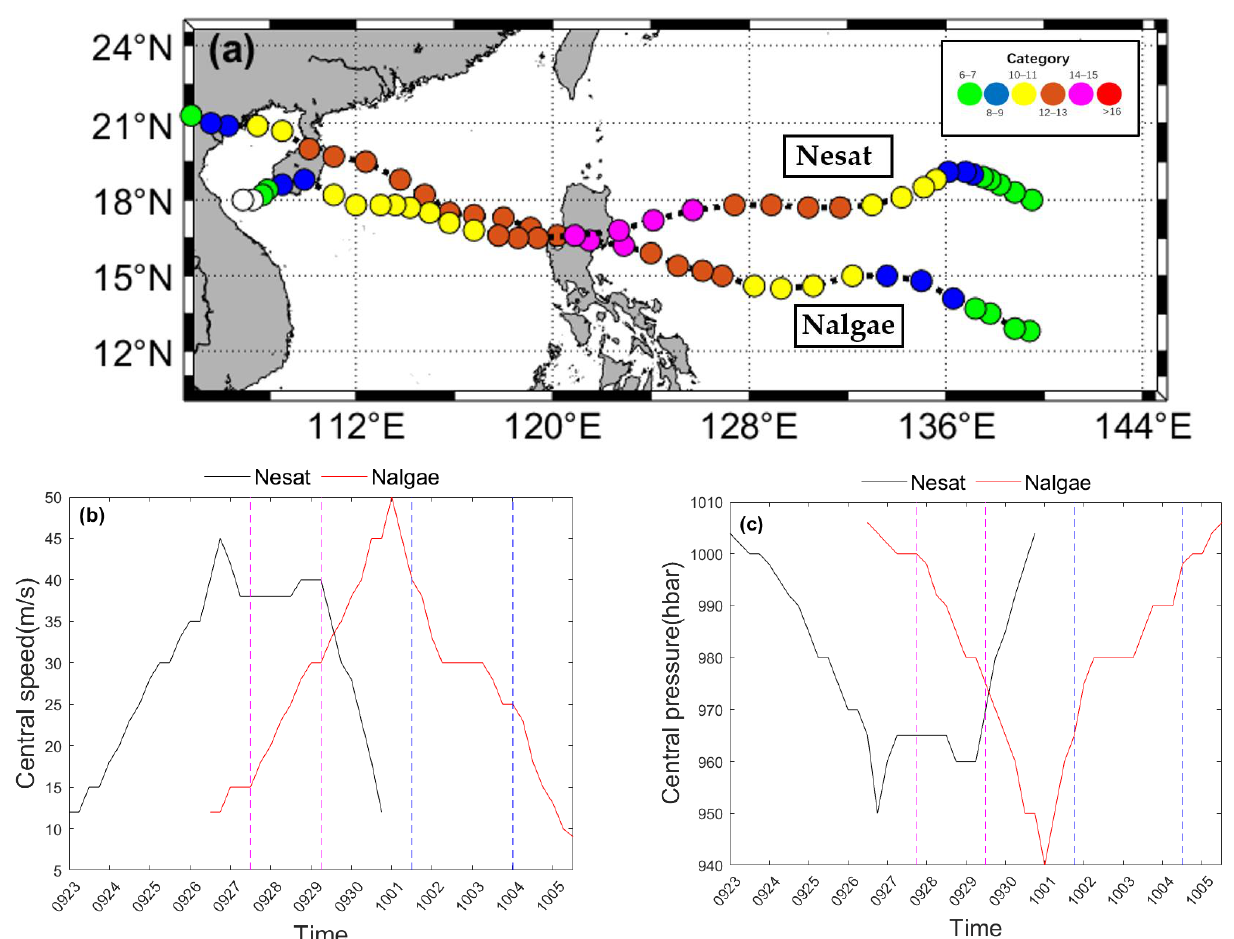
Figure 2. Typhoons Nesat and Nalgae: ( a ) track and intensity (The disc represents the location of the typhoons and the color of the disc represents the intensity of the typhoons); ( b ) central maximum wind speed; and ( c ) central pressure (Between the pink dotted line is the time period of Nesat passing through the South China Sea, and between the blue dotted line is the time period of Nalgae passing through the South China Sea).